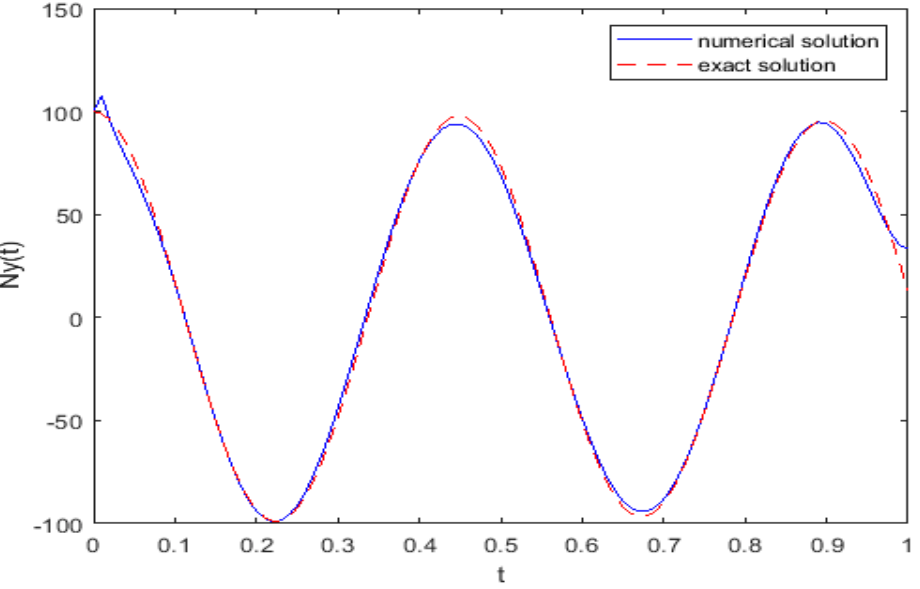
Figure 16. Numerical simulation of solutions of the Bloch equation for N y ( t ) with parameters: α = β = γ = 1, w = 14, T = 1, T = 20, a = 0.9, b = 0.9 .